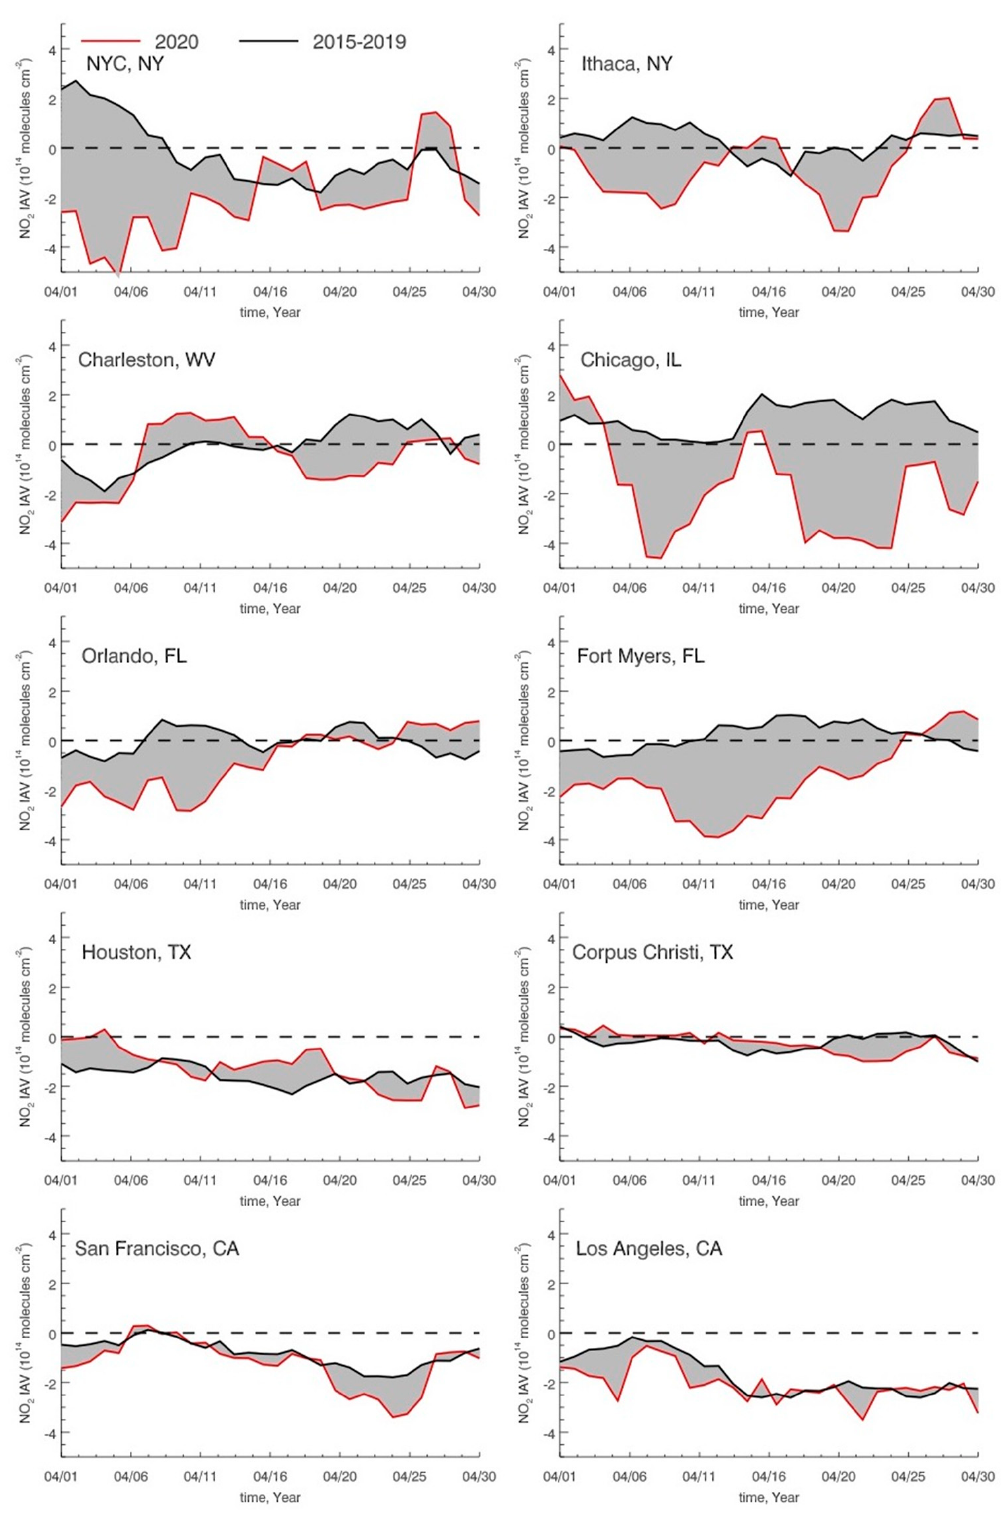
Figure 5. Interannual variability of NO 2 tropospheric column during the base period (solid black line, 2015–2019) and during the lockdown period of the COVID-19 pandemic. The shaded areas represent the difference caused by lockdown measures.